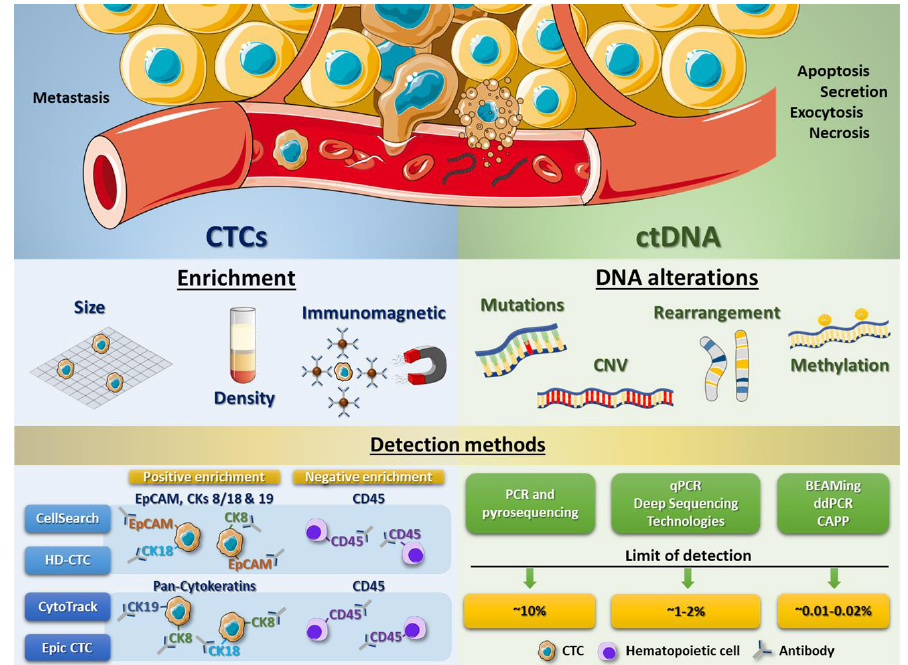
Figure 2. CTC and ctDNA processing methods. Scheme showing some enrichment techniques to isolate CTCs from peripheral blood cells (erythrocytes and leukocytes) and different detection systems based on immunomagnetic assays, using specific antibodies to recognize antigens present in tumour cells (like EpCAM or cytokeratins) as well as to exclude leukocytes (using antibodies against CD45) (left panel). Right panel displays the different DNA alterations (including mutations, copy number variations (CNVs), gene rearrangements or methylation variations) which can be analysed from ctDNA, as well as different detection methods and their correspondent limit of detection.